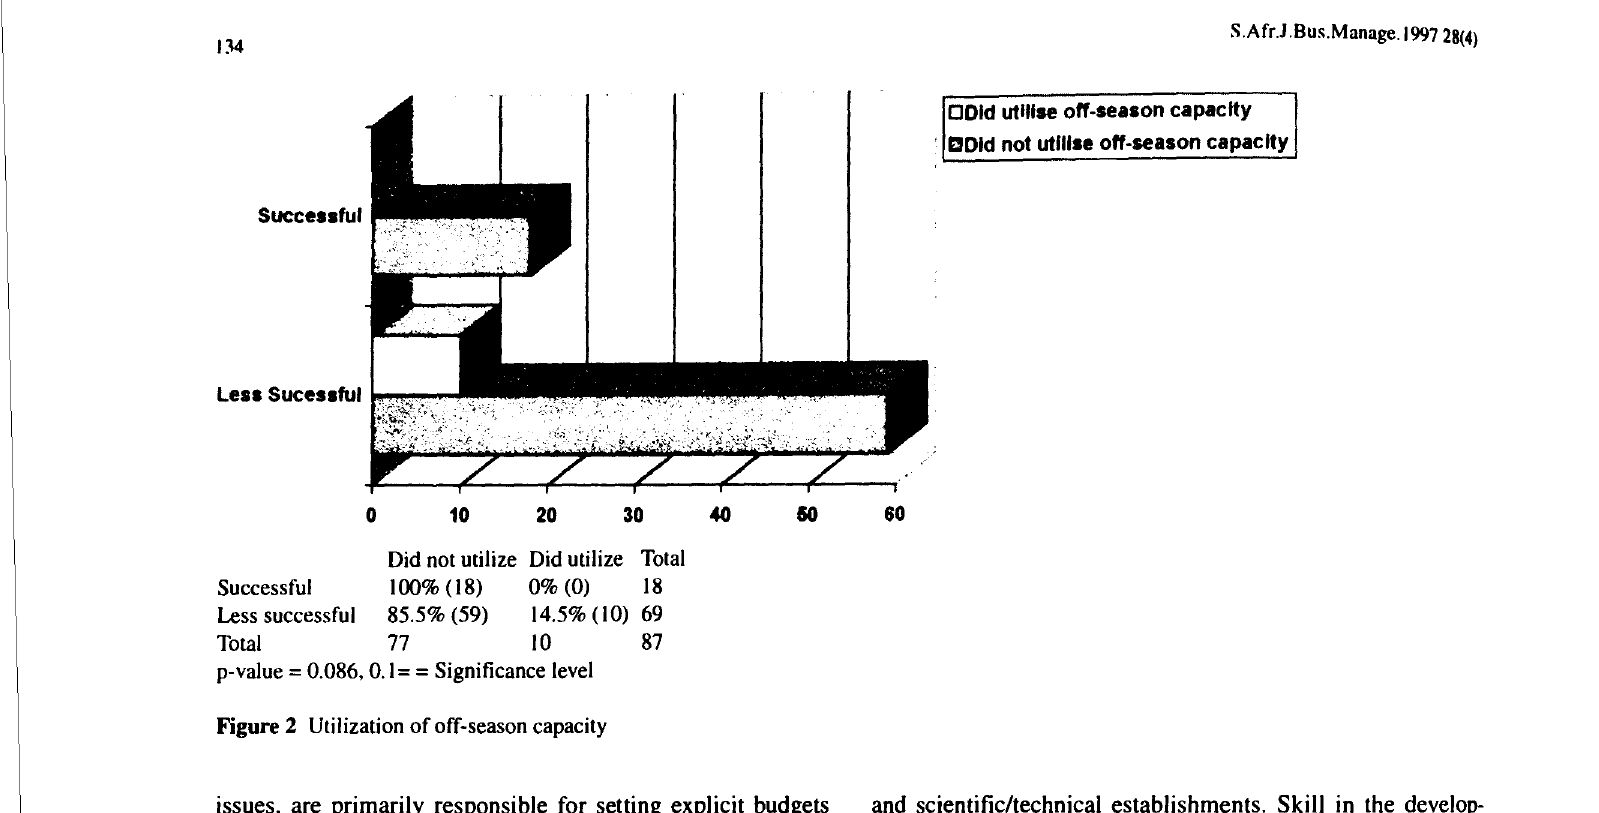
Figure 2 Utilization of off-season capacity